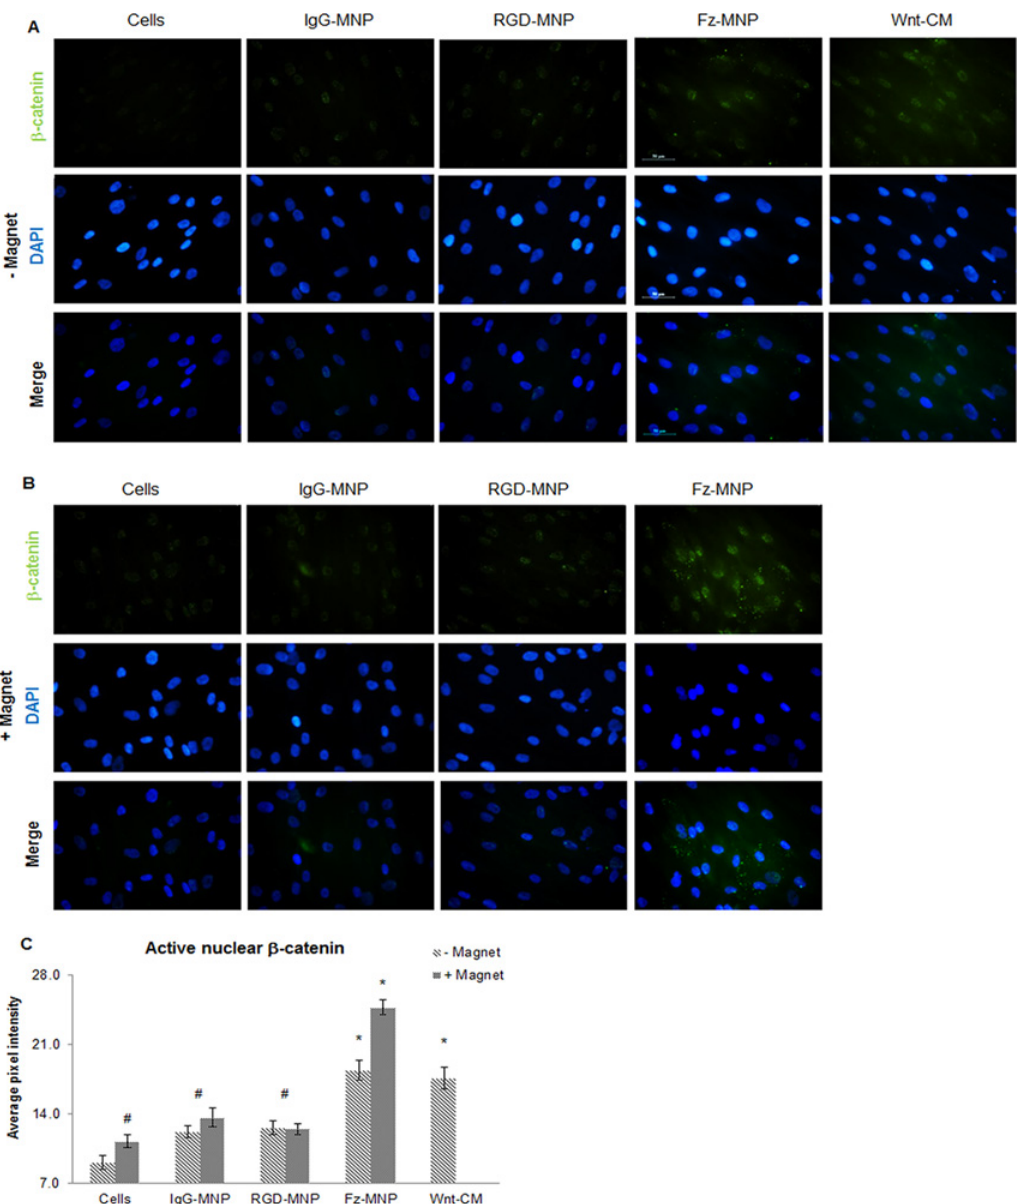
Fig 4. Frizzled-MNP promote β -catenin activation and mobilisation. Fluorescent images showing localisation of active β -catenin (Green) after 24h, DAPI was used to visualise cell nuclei (Blue). Non-treated cells (A) showed negligible β -catenin localisation. Cells treated IgG-MNP or RGD-MNP (A) resulted in a small non-significant increase in nuclear localisation, and addition of magnetic field (B) had no observable effect. Cells treated with magnetic field alone (B) showed a moderate increase in β -catenin localisation. Treatment with Anti-frizzled magnetic nanoparticles (Fz-MNP) without magnet (A) showed notable nuclear localisation with an added effect when used in conjunction with magnetic field (B). Treatment with Wnt-conditioned media (A) also showed notable nuclear β -catenin after 24h. Representative images, n = 3, scale bar = 50 μ m. Quantification of nuclear pixel intensity (C) indicated levels of nuclear (active) β - catenin. Treatment with magnetic field alone, IgG-MNP and RGD-MNP (with or without magnetic field) all caused similar increases in levels of nuclear β - catenin. Fz-MNP and Wnt-CM both increased β -catenin mobilisation to similar levels and an added effect was observed when Fz-MNP were used in conjunction with magnetic field. Average pixel intensities shown, n = 3, error bars represent SEM, * denotes p < 0.05